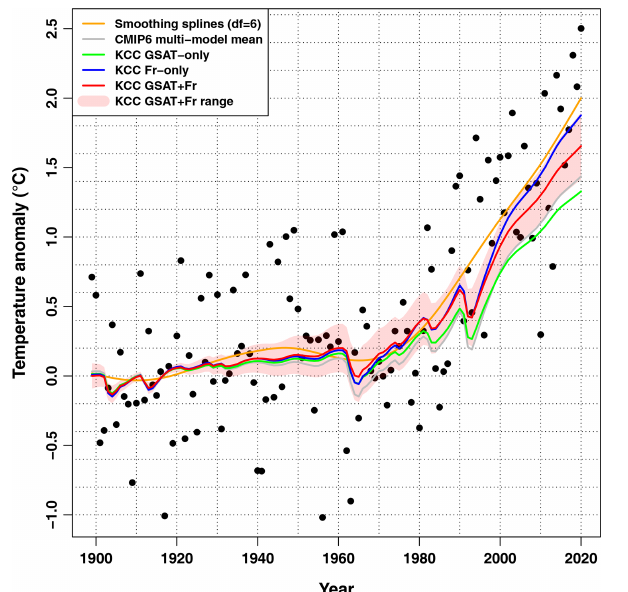
Figure 1. Observations vs. forced response estimates. Observed an- nual mean temperatures over France (1899–2020, black points) are compared to various estimates of the forced response over the same period. Orange: simple smoothing spline estimate using df = 6 (de- grees of freedom). Gray: CMIP6 multi-model mean estimate (best estimate only). Green: result of the KCC constraint using only GSAT observations (best estimate only). Blue: result of the KCC constraint using only regional observations (i.e., over France). Red: result of the KCC constraint using both GSAT and regional obser- vations to build the constraint. The 5%–95% uncertainty range is assessed in the latter